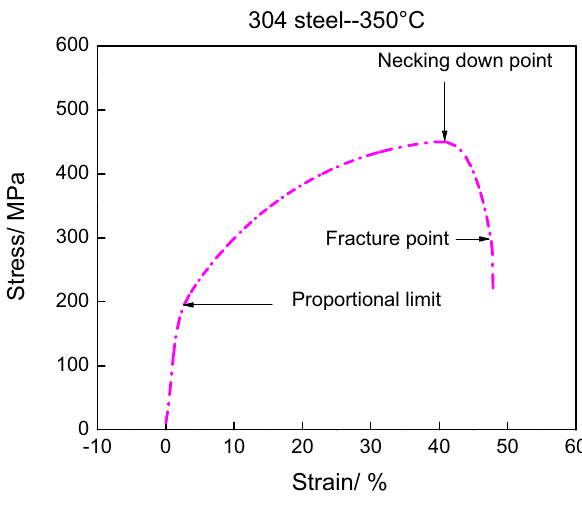
Figure 2: Stress – strain curve of 304 steel at 350°C.